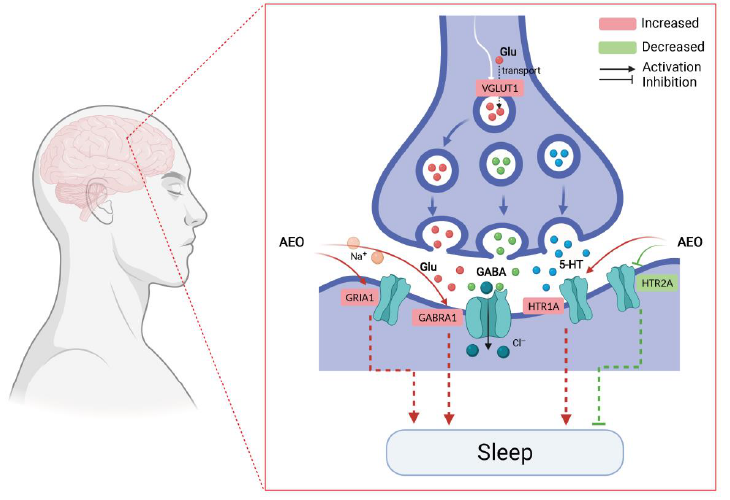
Figure 9. The predicted molecular mechanism of AEO-regulated 5-HT, Glu and GABA multineuro- transmitter pathways in regulating sleep. Table 2. Docking results of five core components with four targets.